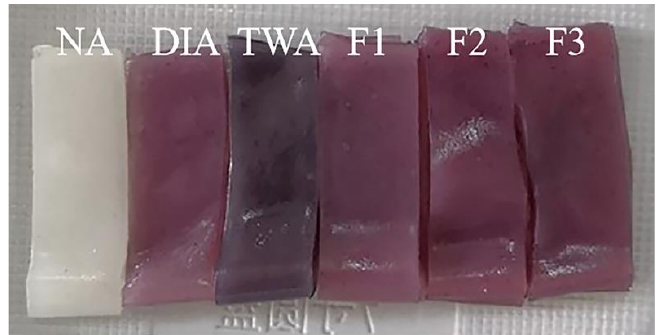
Figure 4. Appearances of the steamed cold noodles that were prepared with tap water and uncol- ored (NA), colored with deionized water-dissolved BRA (DIA), colored with tap water-dissolved BRA (TWA), and colored with tap water-dissolved BRA containing the F1, F2, and F3 chelator formulations.